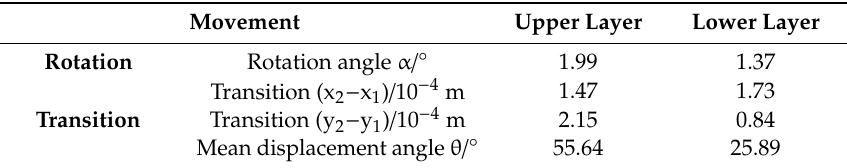
Table 6. Mean value of the rotation angle and transition.